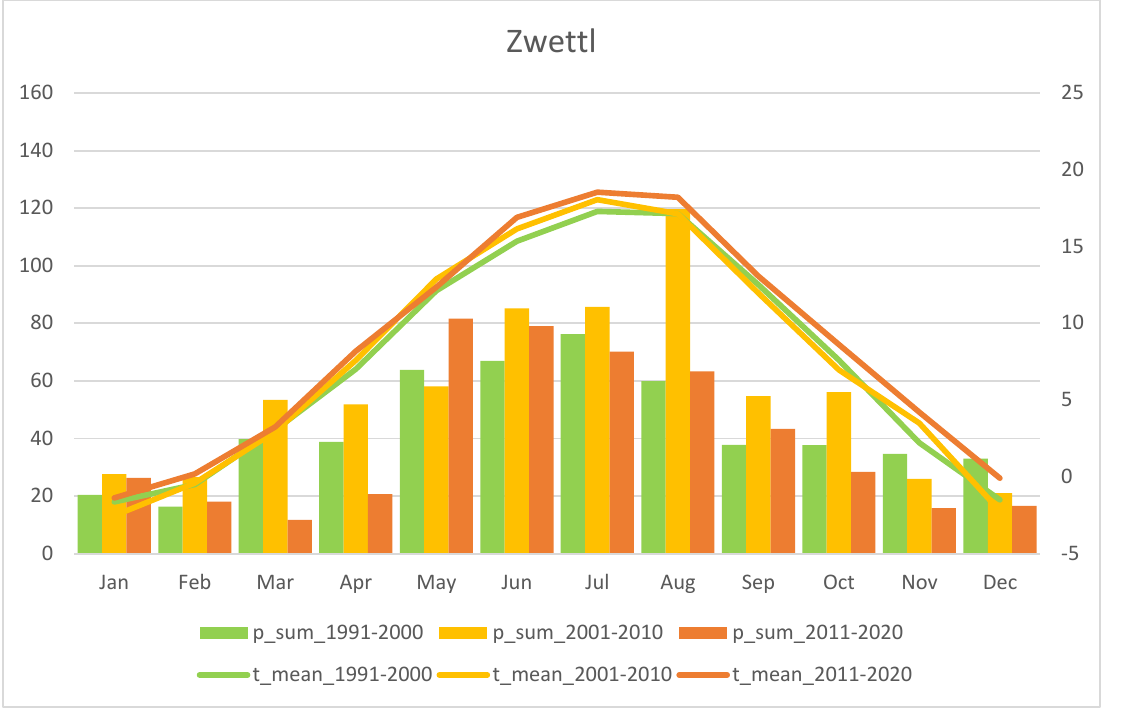
Figure A7. Mean monthly precipitation sum (p_sum; columns) and air temperature (t_mean; lines) for the last three recent decades, i.e. 1991 – 2000, 2001 – 2010, and 2011 –2020. The “Zwettl” station is representative for the Waldviertel region (Source: ZAMG - https://data.hub.zamg.ac.at).